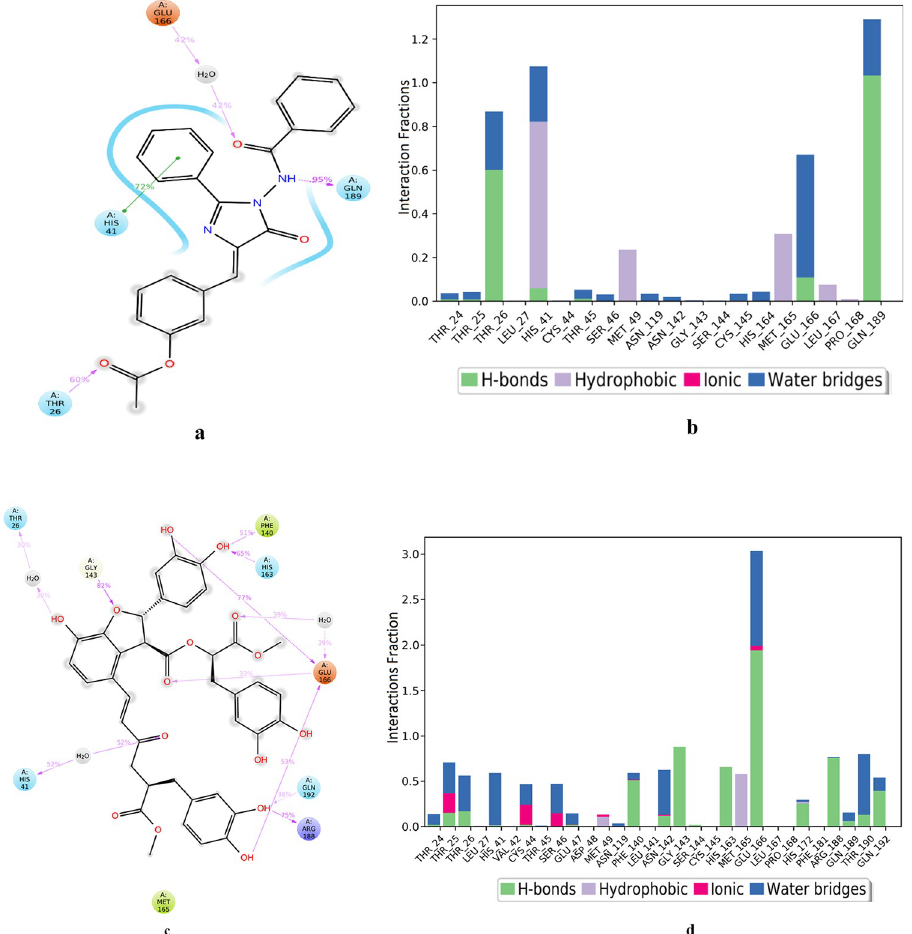
Fig 7. Analysis of molecular interaction and type of contacts with 3CL pro hydrolase after MD simulation. Detailed schematic interaction of (a) compound 2 (AAA396), and (c) compound 3 atoms with binding site residue of hydrolase crystal structures 6LU7, and 6Y2F, respectively. Interaction happening more than 30% of the simulation time are shown. Normalized stacked bar chart of viral protease binding site residues interacting with (b) compound 2 and (d) compound 3 via hydrogen bond, hydrophobic and ionic interactions, and water